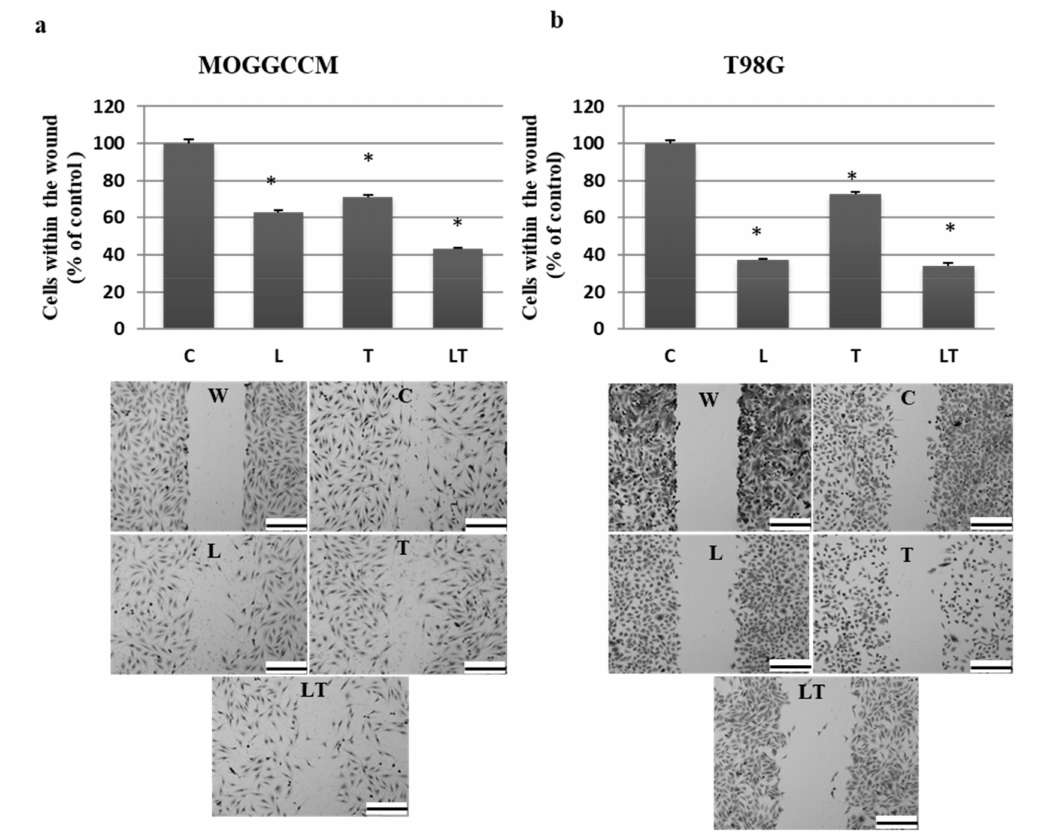
Figure 3. The effect of LY294002 (L) and temozolomide (T) applied alone and in combination (LT) on MOGGCCM ( a ) and T98G ( b ) cell migration estimated by wound assay. A quantitative analysis of migrated cells with representative pictures. W—wound, C—control, * p < 0.01 compared to control, scale bar—400 µ